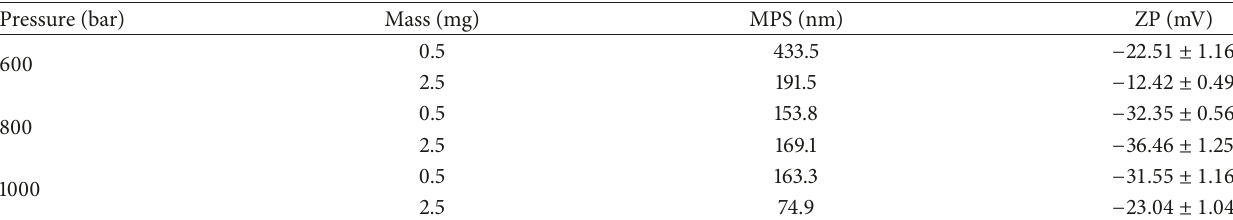
Table 8: Preparation of HCPTNPs with gelatin by